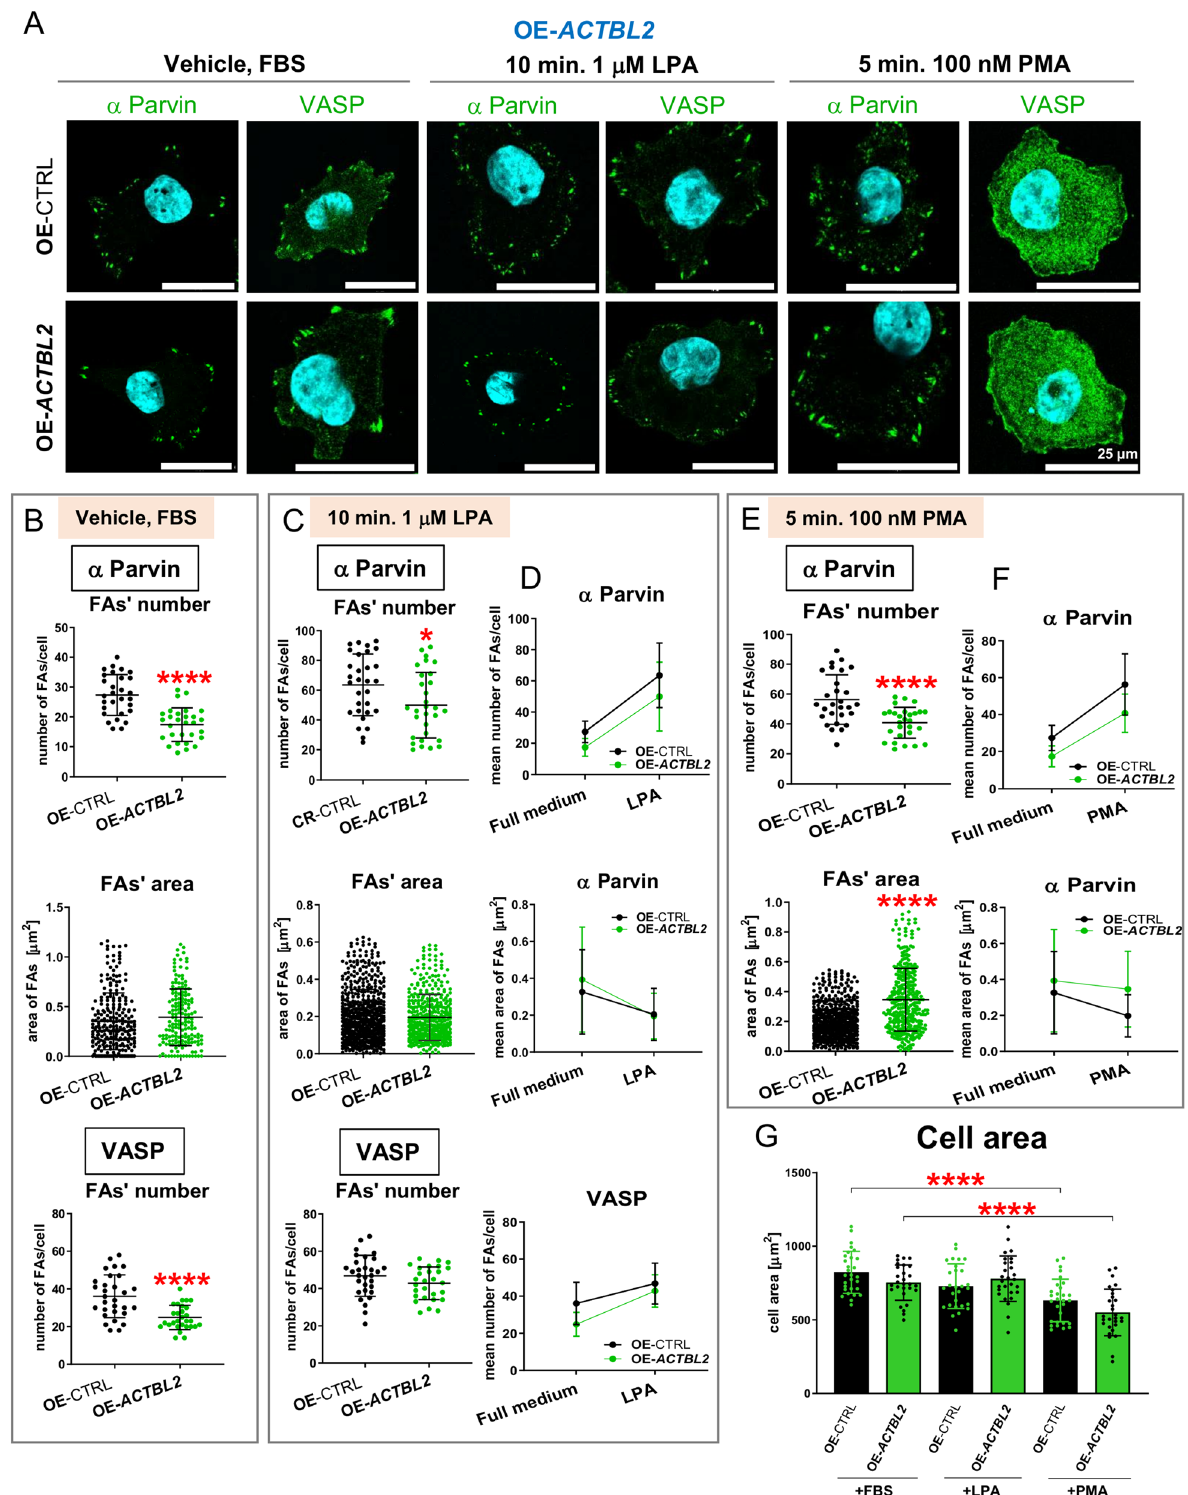
Figure 11. Overexpression of actbl2 resulted in reverse effects on FAs formation relative to ACTBL2 knockout cells. ( A ) Upon seeding the cells on the coverslips and treatment, some of them with either 1 μM LPA for 10 min or 100 nM PMA for 5 min, the cells were fixed and stained with antibodies directed against either α-Parvin or VASP. ( B , C , E ) After taking the photos of stained cells presented in A, the FAs number and their area were measured and presented as bar charts (n = 30). ( D , F ) Slope graphs showing trends upon LPA or PMA stimulation in the number and surface area of focal adhesion. ( G ) The cell surface area of OE-CTRL and OE- ACTBL2 cells growing in the presence of FBS or upon treatment with either LPA or PMA was measured (n = 30). Results are expressed as the mean ± SD; p ≤ 0.05 (*), p ≤ 0.0001